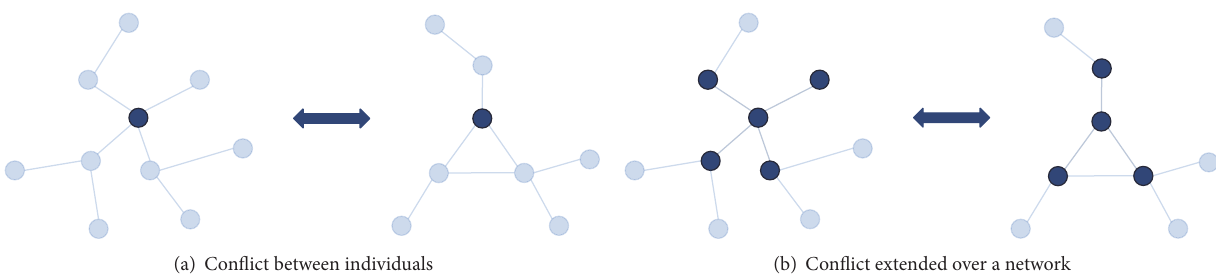
Figure 6: Formation of conflicts of various sizes over a network. A dispute initiated between two persons (illustrated in (a)) may develop into a larger conflict (in (b)), following the networks. This escalation occurs with the probability 𝛽 and may repeat several times, creating conflicts between two arbitrary clusters of various sizes.